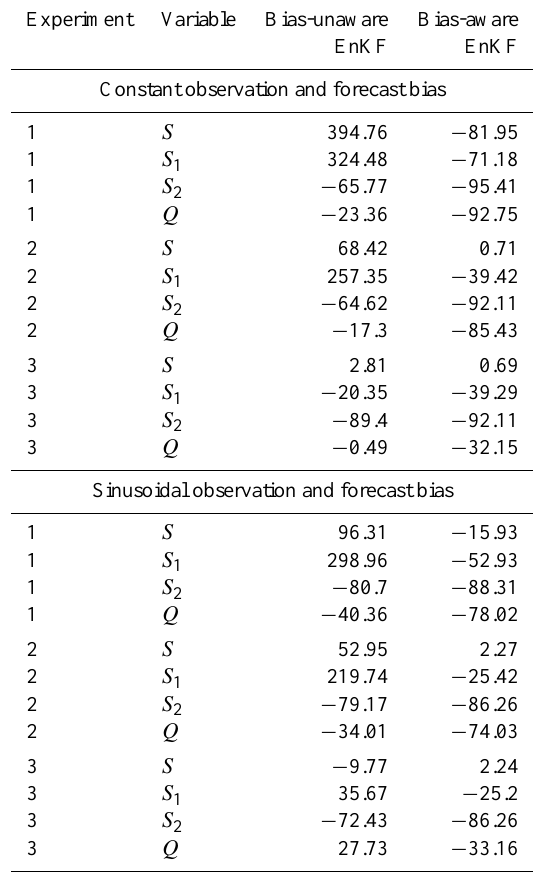
Table 3. Relative RMSE values of the analyzed results from the bias-unaware and the bias-aware